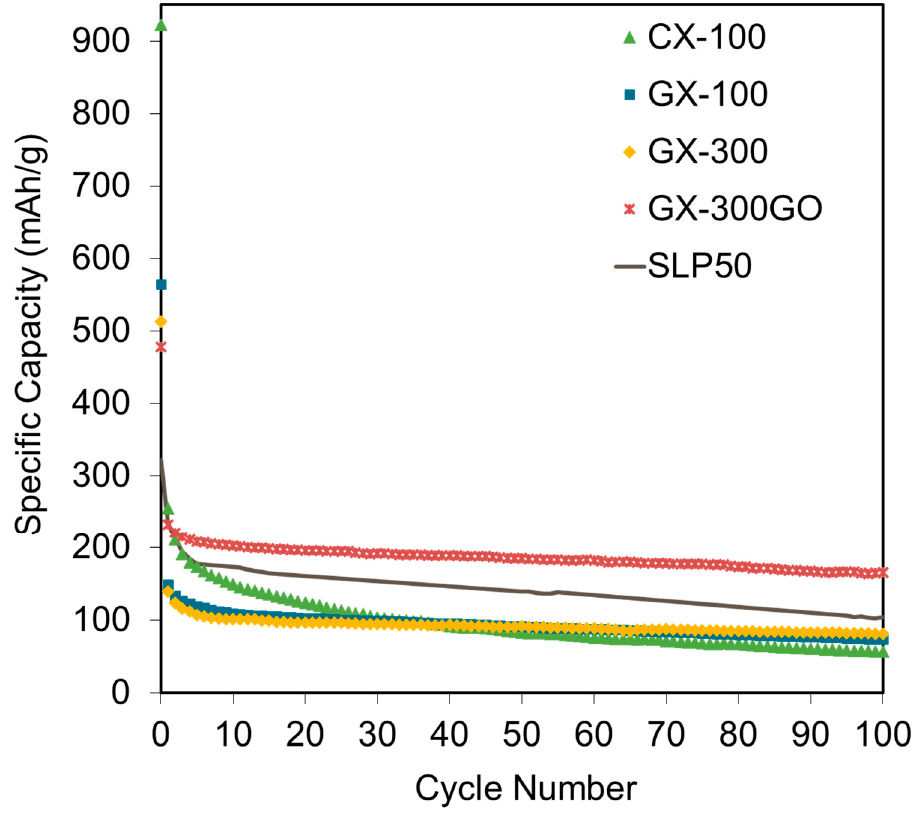
Figure 6. Cycling performance results for the xerogels studied and the reference material.